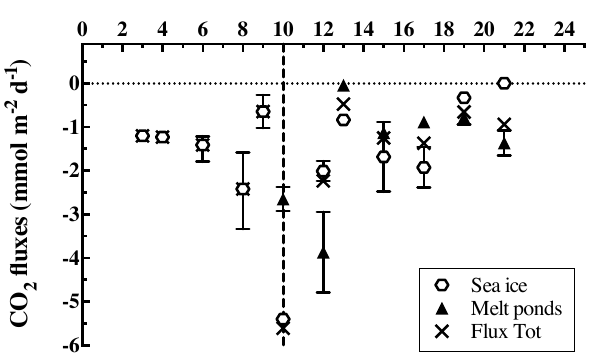
Figure 7. CO 2 fluxes (mmolm − 2 day − 1 ) measured over sea ice (white hexagons), melt ponds (black triangles). The total fluxes are represented by the black